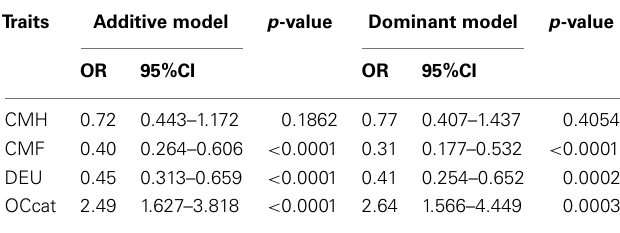
Table 4 |Association of TBX5 c.54T > C with OC lesion